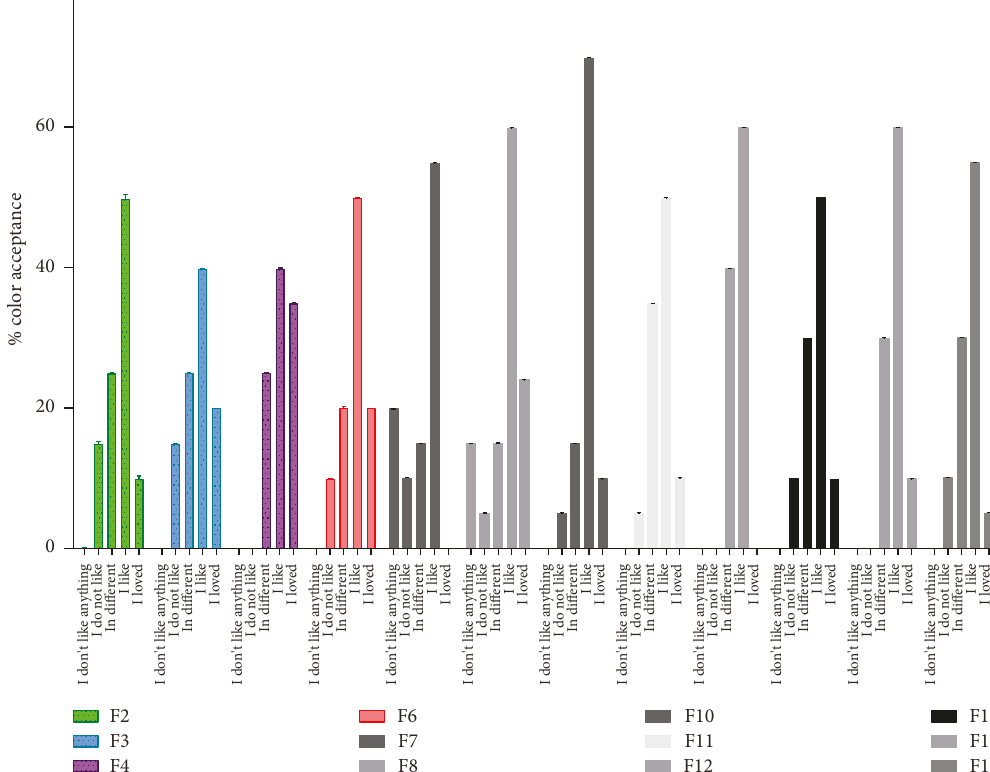
Figure 13: Percentage of color acceptance by panelists for di ff erent formulations.